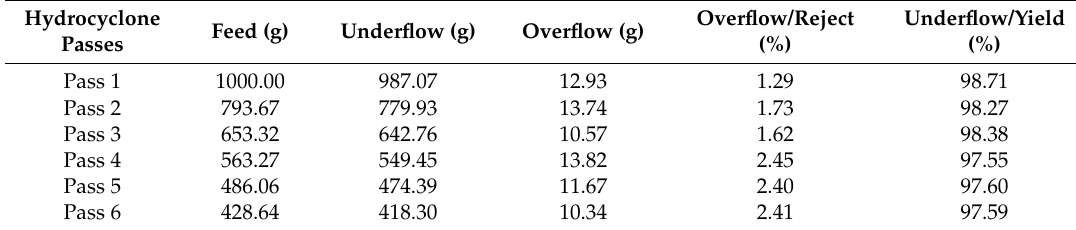
Table 1. Hydrocyclone data for hydrogen decrepitated NdFeB.